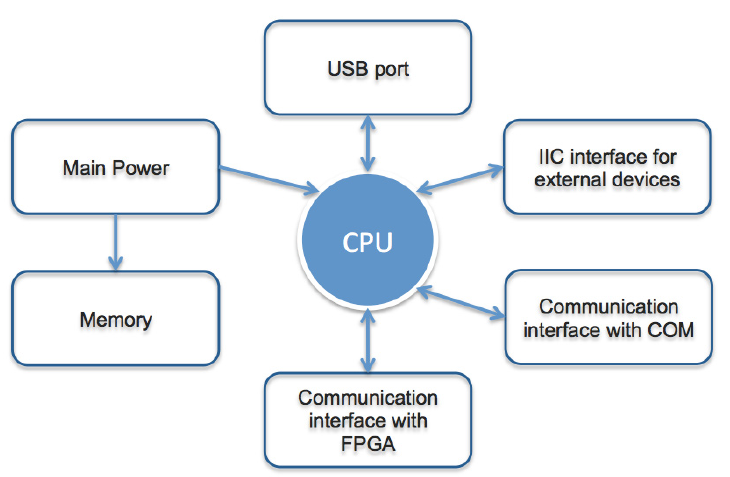
Figure 3. Flowchart of the camera MASTER